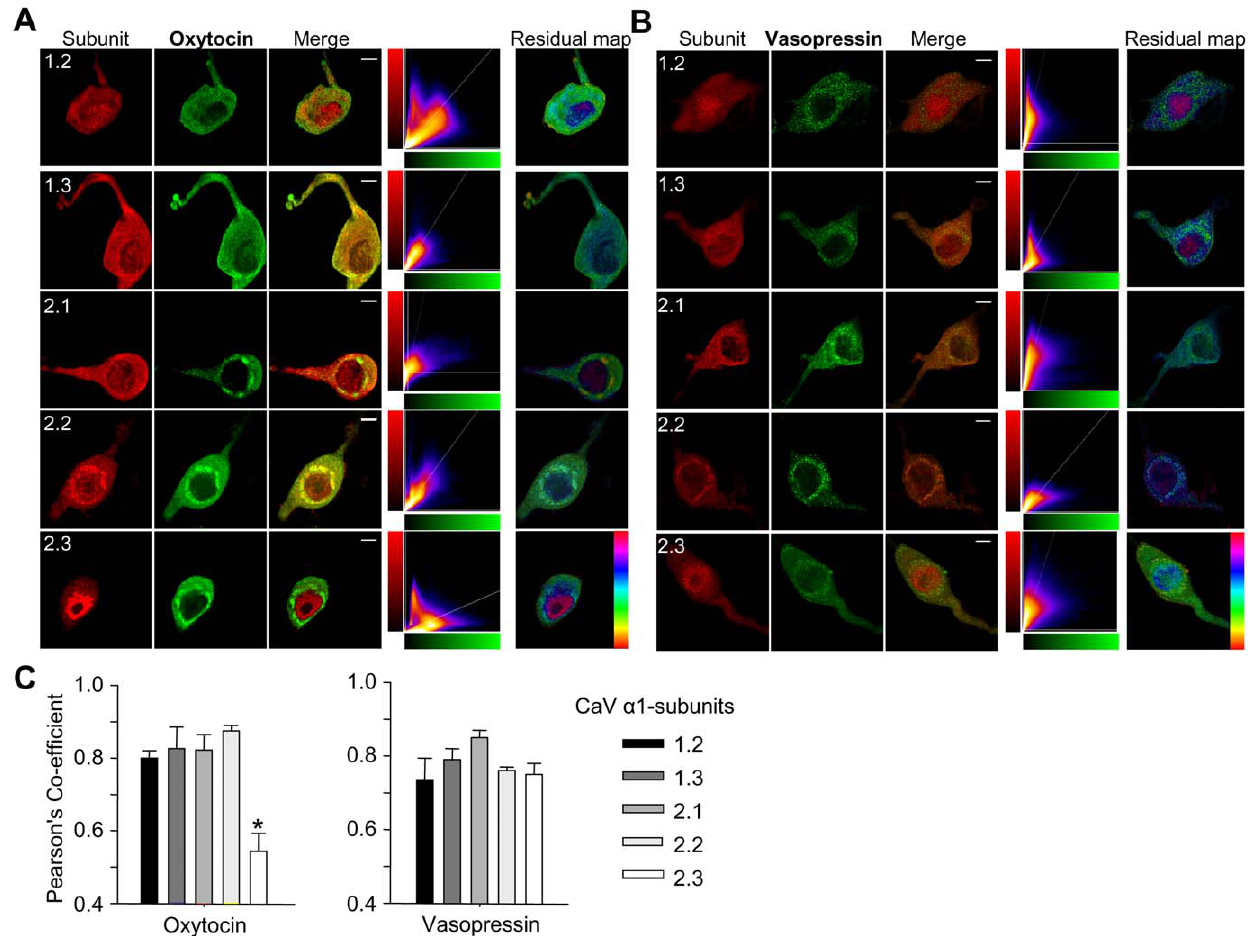
Figure 3. Ca 2 + channel distribution in isolated magnocellular neurons. Immunostaining for Ca v a 1 subunits (red) in acutely-dispersed oxytocin ( A ) and vasopressin neurons ( B ) (green). Immunostaining for all subunits was observed in the soma and dendrites, in both in the cytoplasm and at the plasma membrane. Immunostaining for oxytocin and Ca v 2.1 and 2.2 also showed strong perinuclear staining. The merged images show areas of coincidence in yellow (third column). Scatter plots (fourth column) show co-variance of subunit signal with the oxytocin signal for each voxel The residual map corresponds to weighted residuals from the line fit to the scatter plot, thus indicating fluorescent channel covariance (hue from –1 to 1, with cyan corresponding to zero residual). ( C ) Quantification of covariance data of oxytocin or vasopressin and one of the five a 1-subunits using Pearson’s coefficient values (n=5 per group). Means 6 S.E.M. * P , 0.05, one-way ANOVA followed by Holm-Sidak post-hoc test vs Ca v 2.2. Scale bars 10 m